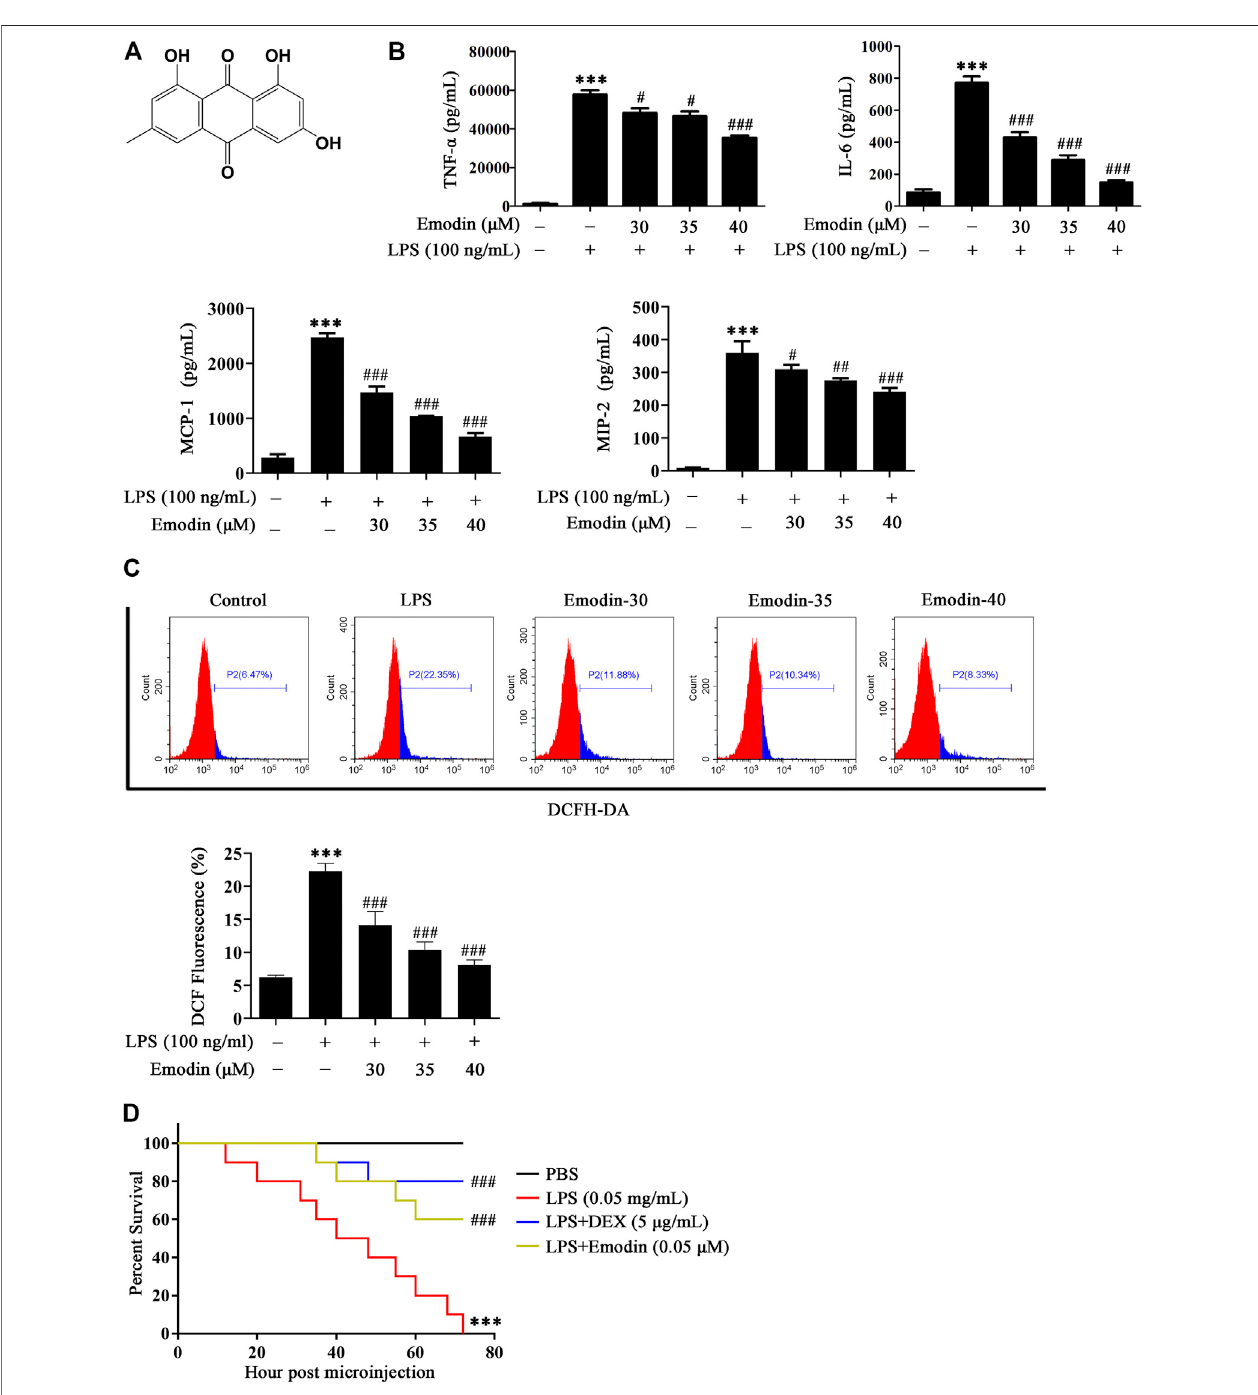
FIGURE 1 | Emodin suppresses in fl ammatory response and oxidative stress in vitro and in vivo . (A) The chemical structure of emodin. (B) Emodin inhibits the productionofin fl ammatoryfactorsTNF- α ,IL-6,MCP-1,andMIP-2inLPS-inducedRAW264.7cells.RAW264.7cellswerepretreatedwithemodin(30,35,or40 μ M)for 2 h and then treated with LPS (100 ng/ml) for 18 h. The levels of TNF- α , IL-6, MCP-1, and MIP-2 in supernatant were measured by ELISA. (C) Emodin inhibits oxidative stressinLPS-inducedRAW264.7cells.RAW264.7cellswerepretreatedwithemodin(30,35,or40 μ M)for2 handthentreatedwithLPS(100 ng/ml)for18 h.The cells were collected and the ROS production was determined by fl ow cytometric analysis. Data are presented as mean ± SEM, n = 3. *** p < 0.001 compared with the control group, ### p < 0.001 compared with the LPS group. (D) Protective effects of emodin on zebra fi sh challenged by LPS. 3 dpf zebra fi sh larvae were yolk- microinjected with LPS (0.5 mg/ml), and then treated with emodin (0.05 μ M) or DEX (5 μ g/ml). Survival ofzebra fi sh larvae wasassessed within 72 h. PBS-microinjected zebra fi sh larvae were served as the negative control. Data are presented as mean ± SEM. *** p < 0.001 compared with the PBS group, ### p < 0.001 compared with the LPS